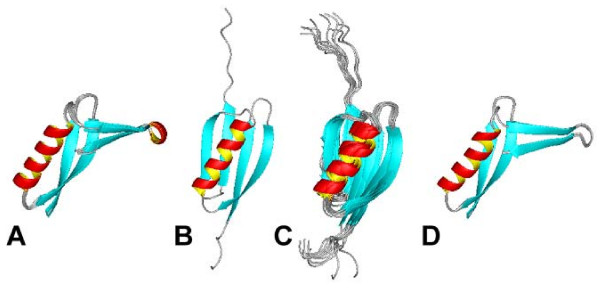
Unbiased refinement of the solution structure of imunoglobulin binding domain of protein G. Parameters used for restraint generation are the same as shown in Table 1 and Table 2. A: NMR structure (10 monomers of the dimeric structures). 2948 distance, 260 angle and 41 hydrogen bond restraints were obtained (R1*). The RMSD is 0.022 nm. The Ramachandran plot delivers 90% in most favored regions and 10% in additional allowed regions. B: Single monomeric X-ray structure. 1888 distance and 243 angle restraints were obtained for generation of the X-ray structure bundle (C). C: X-ray structure bundle (created as described in the materials and methods section). 2762 distance, 241 angle and 45 hydrogen bond restraints were obtained (R2*). D: 10 final refined structures obtained using the ISIC algorithm (restraint combination of A and C, 2948 distance, 224 angle and 26 hydrogen bond restraints were obtained). The RMSD is 0.008 nm for the backbone atoms. The Ramachandran plot delivers 92% in most favored regions and 8% in additional allowed regions.